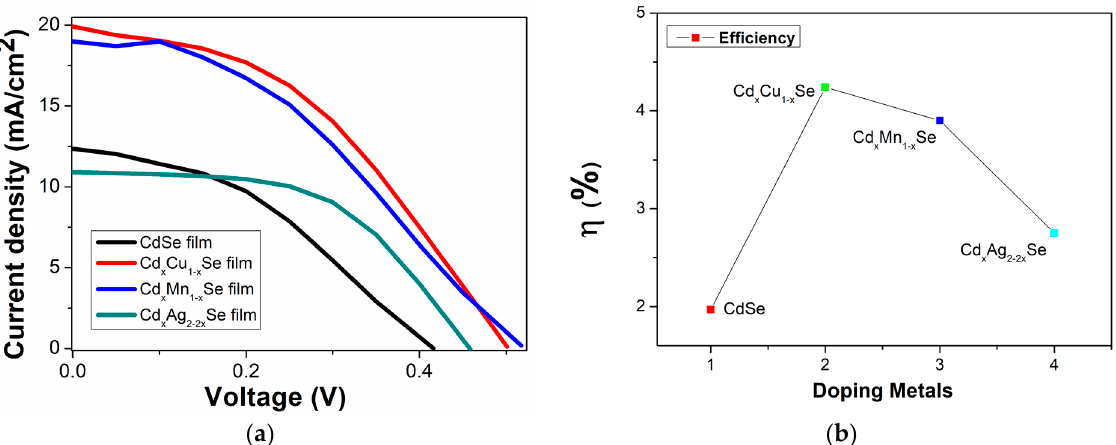
experimental values are recorded in Table 2.